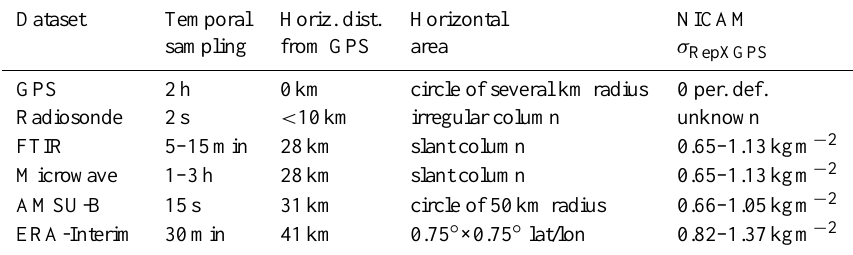
Table 3. Temporal and horizontal sampling characteristics of the different datasets. For GPS, FTIR, and the microwave, the temporal sampling simply is the instrument integration time. For the radiosonde it should be noted that, although the sensor gives an instantaneous point measurement of humidity, the IWV calculated from it will be along the flight path of the balloon (both temporally and spatially), so it will not necessarily correspond to the actual instantaneous IWV over some horizontal position. For AMSU-B, the spatial scale comes from our data processing, which is described in Sect. 2.5, not from the native resolution of the instrument, and the time given is the approximate time between the first and last AMSU pixel used for the collocation. For ERA-Interim, the given numbers are the grid resolution. The last column gives the NICAM-based estimate of the error of representativeness σ RepXGPS for the comparison of the respective dataset to the GPS data. For the radiosonde our method is too coarse to provide an estimate, but there still will be a representativeness error. Dataset Temporal Horiz. dist. Horizontal NICAM sampling from GPS area σ RepXGPS GPS 2h 0km circle of several km radius 0 per. def. Radiosonde 2s < 10km irregular column unknown FTIR 5–15min 28km slant column